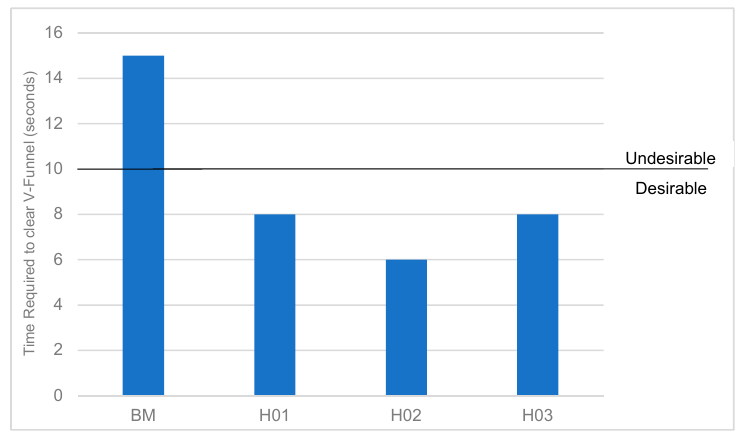
Figure 17. The time taken for hybrid SCC samples to pass through a V-Funnel.